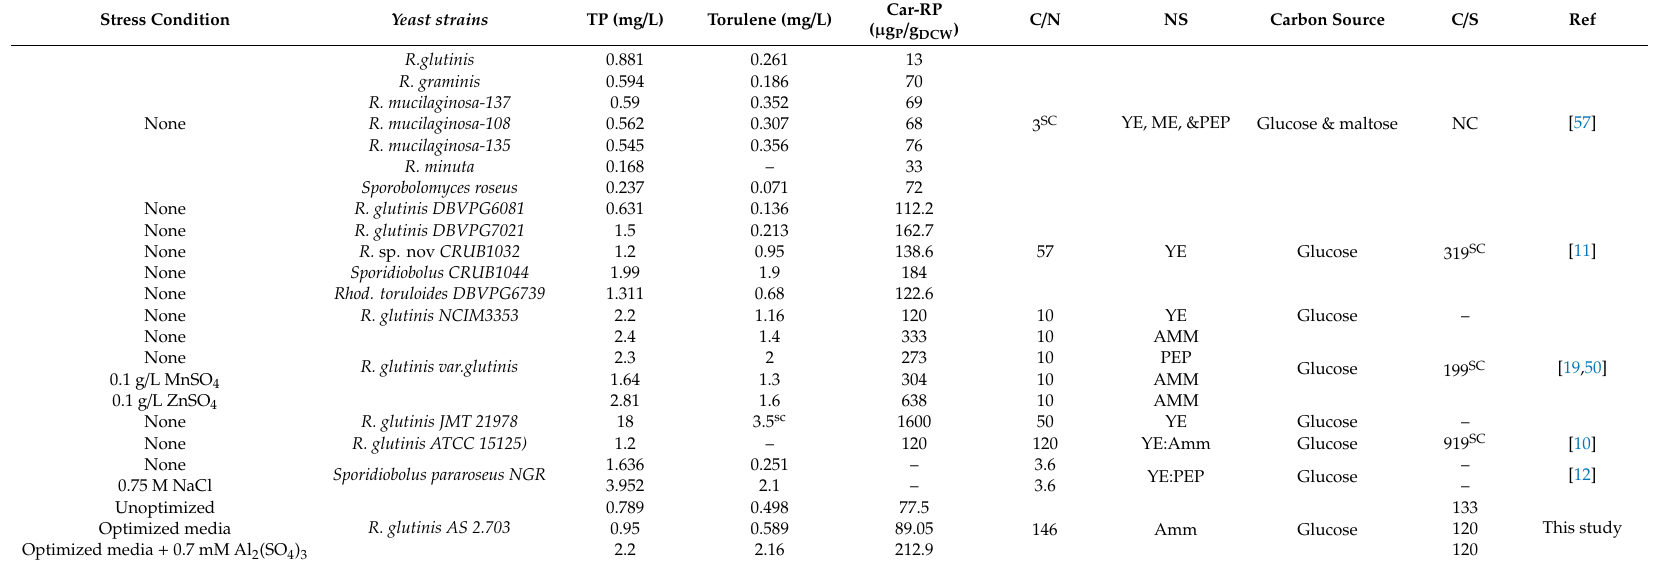
Table 6. Comparative studies from previous reports detecting the total pigment (mg / L) and torulene(mg / L) and carotenoid relative productivity (Car-RP)( µ g P / g DCW ) production by di ff erent red yeast strains under di ff erent C / N ratio, C / S, nitrogen sources and some stress condition. Stress